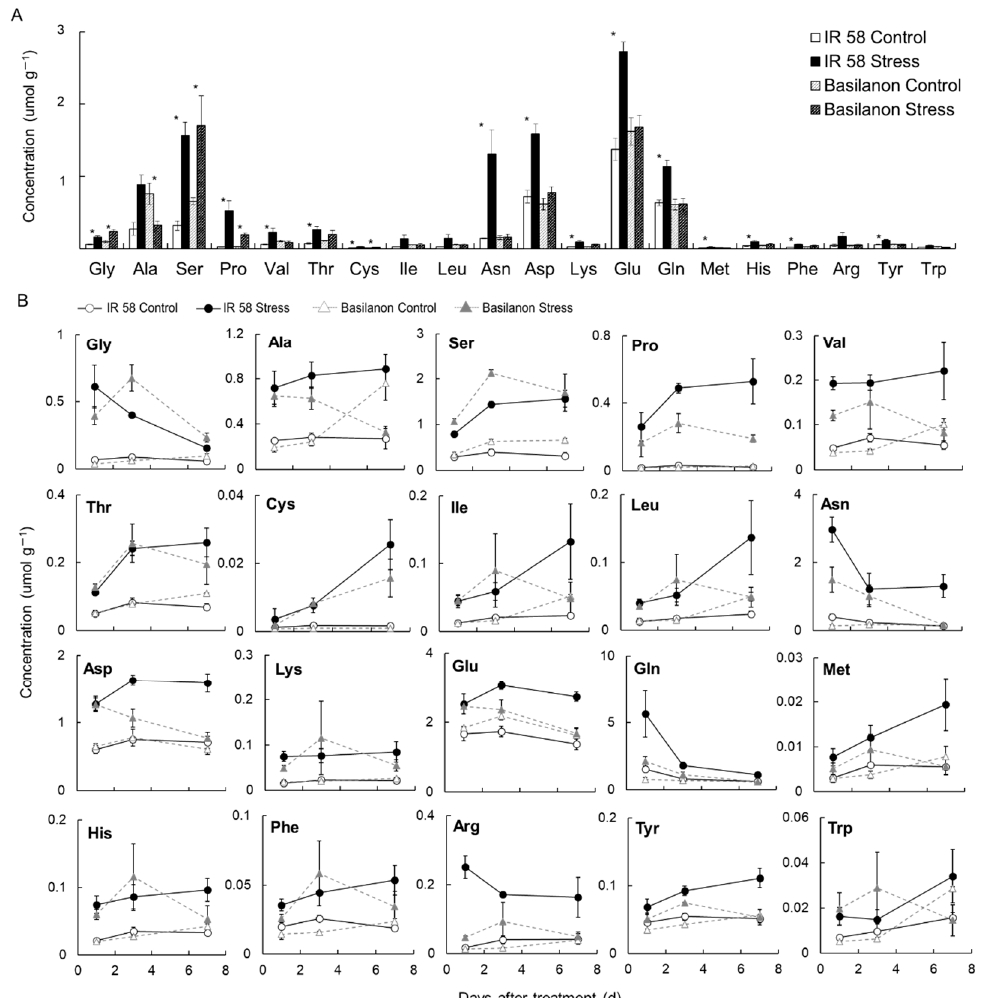
Figure 3. E ff ect of osmotic stress on root amino acid concentration in two rice cultivars. ( A ) Twenty amino acid concentration in roots at 7 days after treatment. ( B ) The changes in amino acid concentration in roots. Bars indicate the standard error ( n = 3). An asterisk represents a significant di ff erence between treatments in each cultivar ( p < 0.05, t -test).